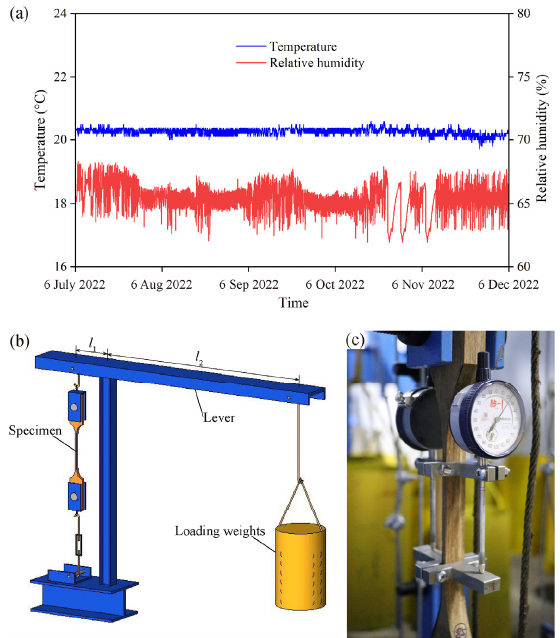
Figure 4. Long-term test: ( a ) constant environment; ( b ) schematic drawing of a lever system; ( c ) measuring creep strain.